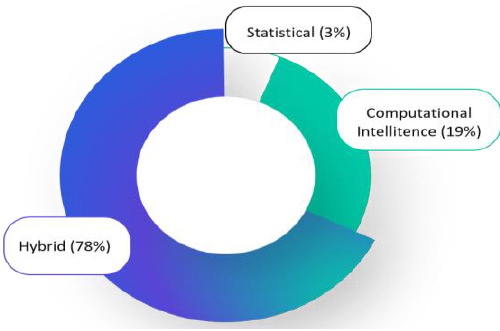
Figure 20. Classification by type of proposed model.